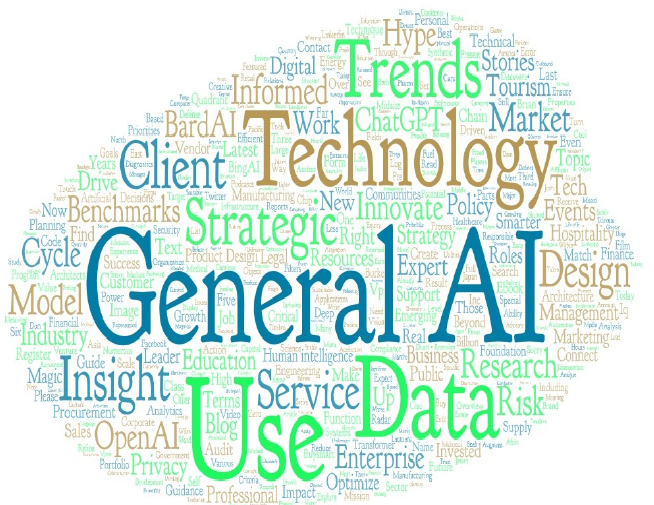
Figure 5. Word cloud from the publications considered for this study. Source: authors’ compilation.